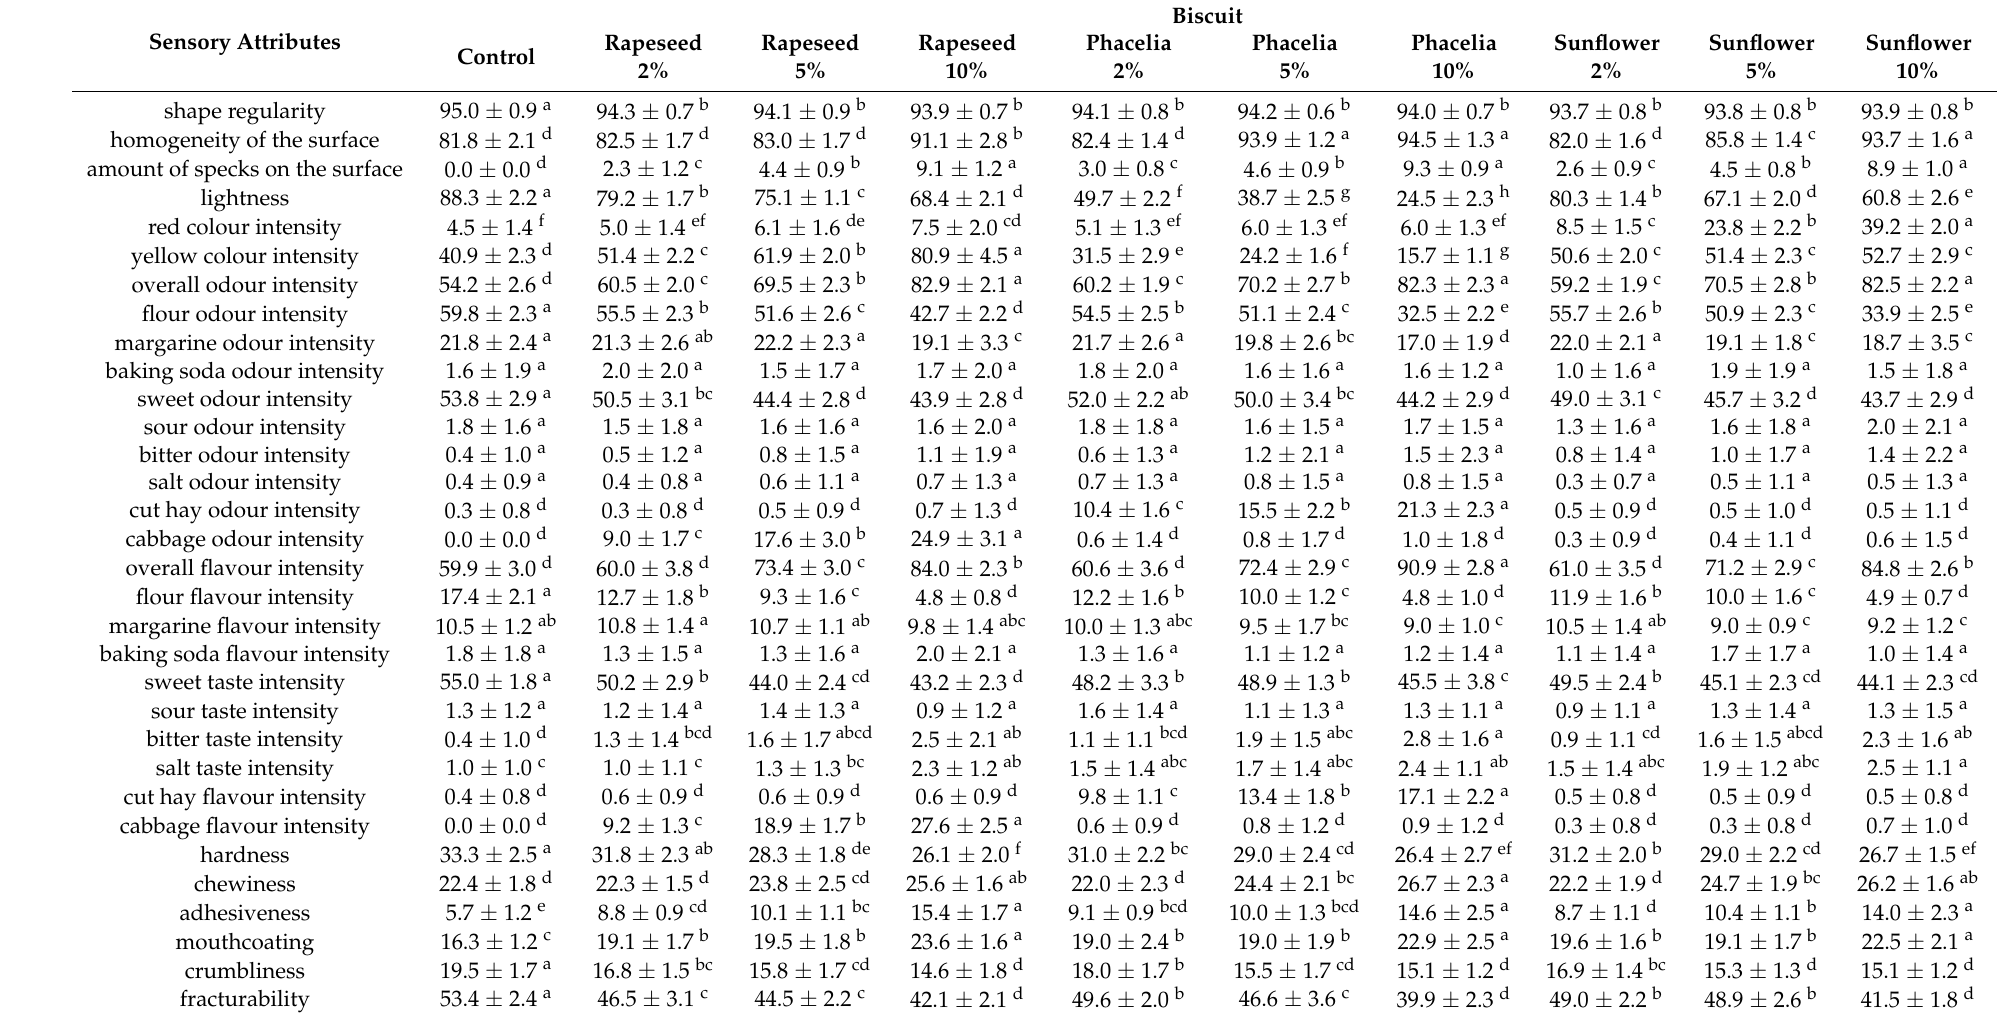
Table 9. Sensory properties of biscuits (quantitative descriptive analysis,